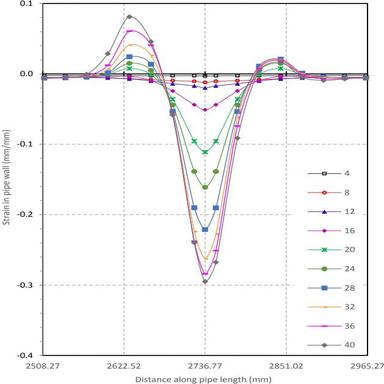
Evolution of strains for full-length pipe model.